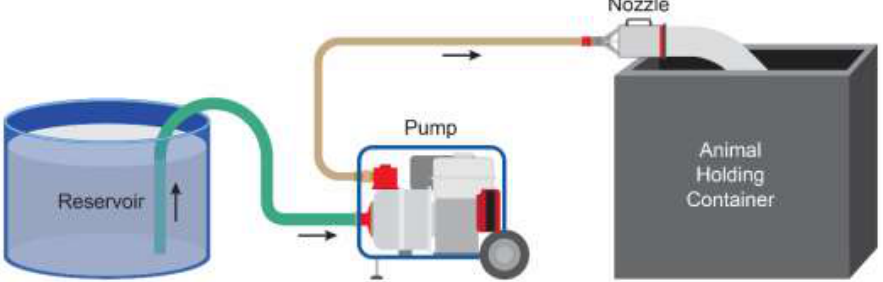
Figure 3. Schematic drawing of the equipment setup used for water-based foam depopulation. The foam concentrate and water are mixed to the desired concentraiton in the Reservoir. The water and foam concentrate solution is delivered to the medium-expansion foam handline nozzle via hoses connected to a gasoline-powered high-pressure water pump.